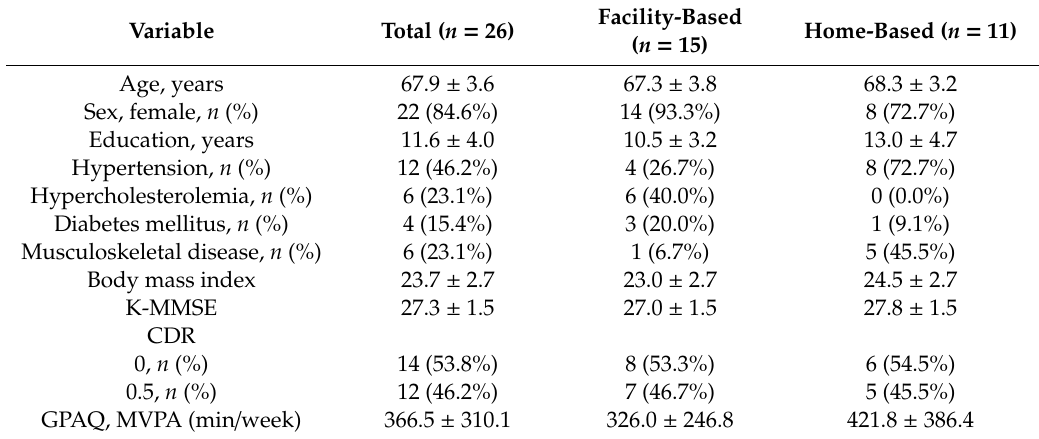
Table 2. Components and progression of the exercise program.